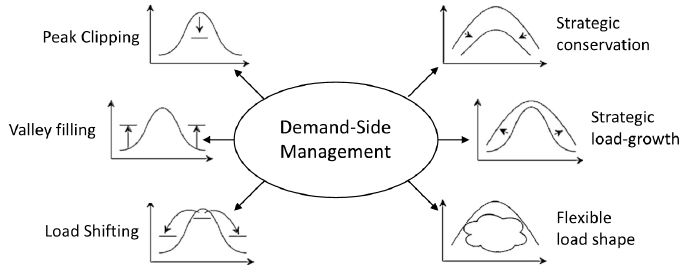
Figure 2. Classification of the main objectives of Demand-Side Management. Adopted from [25].